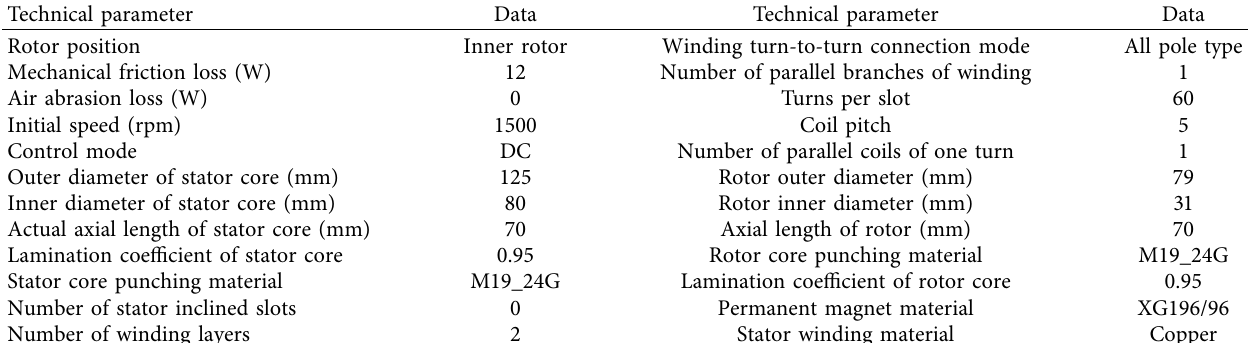
Table 1: Main technical parameters of permanent magnet brushless direct current (DC) motor.